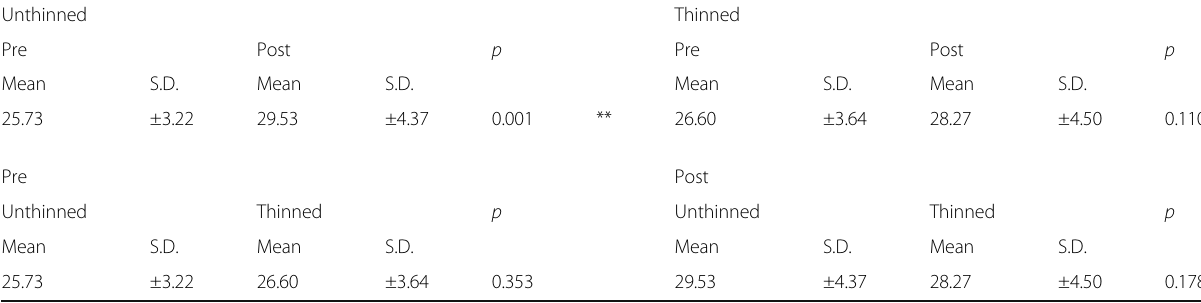
Table 12 Results of multiple comparison tests between before and after thinning (setting) and pre – post (exposure to the forest) for Restorative Outcome Scale (subjective restorativeness) Unthinned Thinned Pre